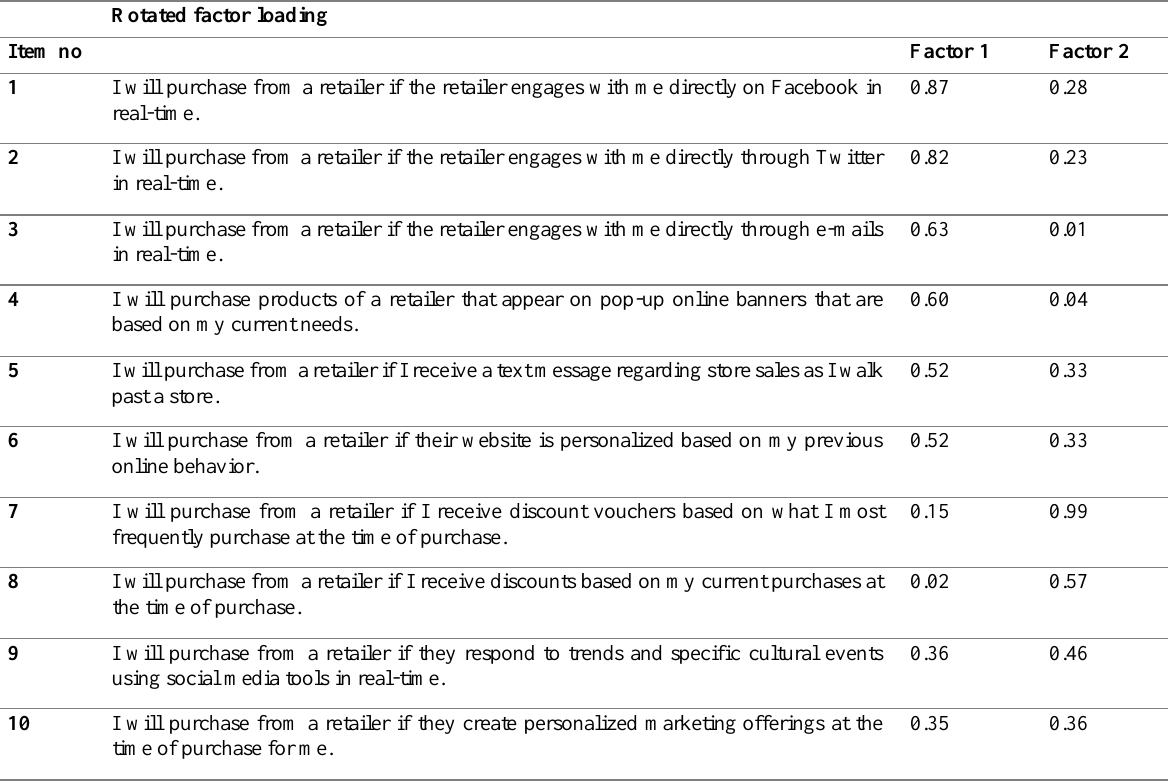
Table 3: Factors that influence consumer behavior when targeted with RTM campaigns Rotated factor loading